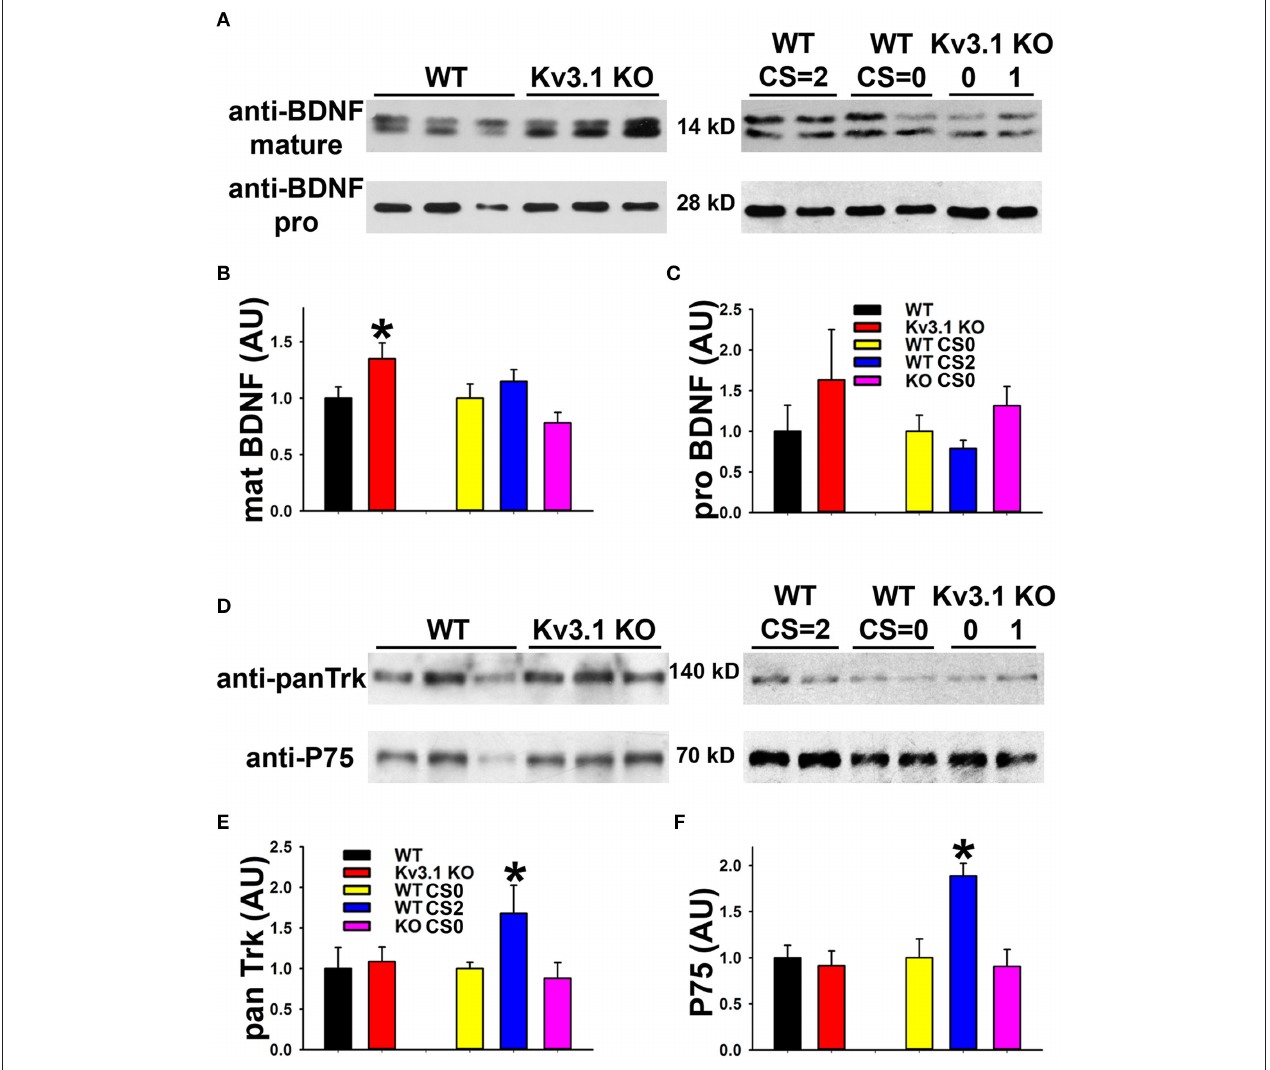
FIGURE 6 | Biochemical analysis of BDNF and its receptor levels in Kv3.1 KO and EAE mice. (A) Western blot analysis of alterations of mature BDNF and pro-BDNF expression levels in Kv3.1 KO mice and at different stages of EAE. (B) Summary of mature BDNF levels. (C) Summary of pro-BDNF levels. (D) Western blot analysis of alterations of pan-Trk and P75 expression levels in Kv3.1 KO mice and at different stages of EAE. (E) Summary of pan-Trk levels. (F) Summary of P75 levels. Unpaired Student t –test between WT and Kv3.1 KO mice: * p < 0.05. One-way ANOVA followed by Dunnett’s test in EAE mice. * p <